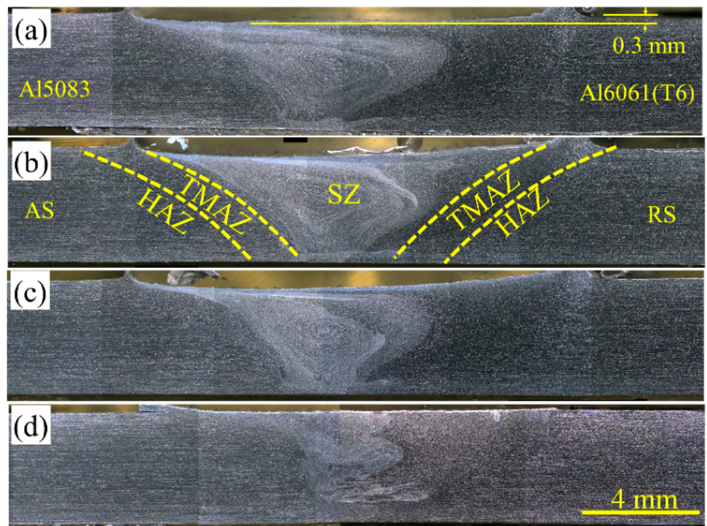
Figure 2. Macro photos of the dissimilar joint of Al5083-Al6061(T6) under different welding param- eters; Samples ( a ) A-1, ( b ) C-1, ( c ) D-1, and ( d ) C-4. ters; Samples ( a ) A-1, ( b ) C-1, ( c ) D-1, and ( d )